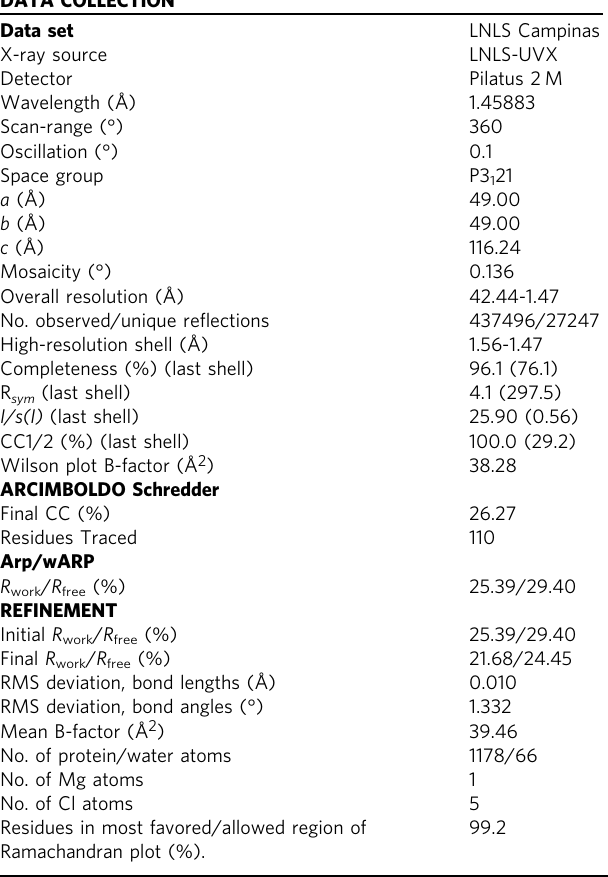
Table 1 X-ray data collection and structure re fi nement statistics for MreC Pa(97-258)